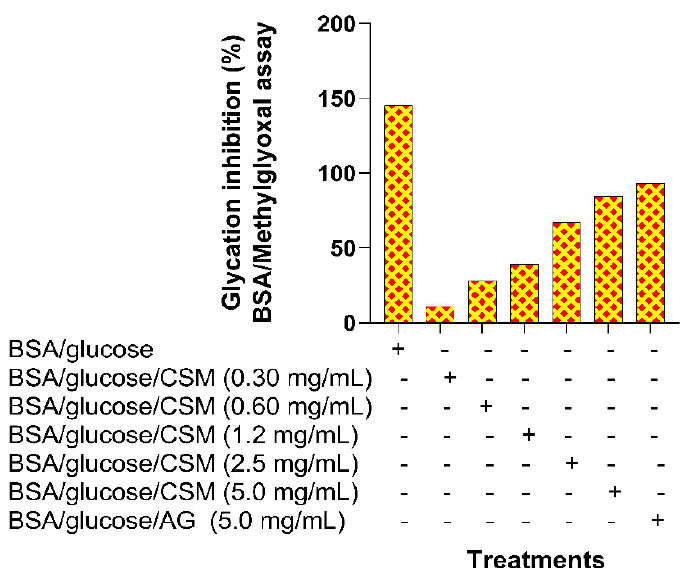
Figure 4. CSM inhibitory activity in the BSA/methylglyoxal model. Values are expressed as a percent- age of glycation inhibition. CSM; methanol extract from the seed of S. purpurea . AG; aminoguan- idine.